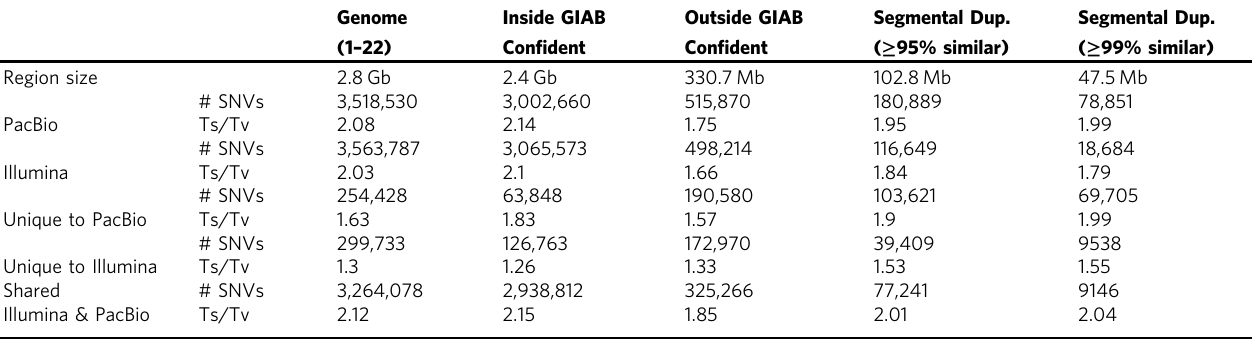
Table 2 Comparison of PacBio and Illumina SNV calls for NA12878 Genome Inside GIAB Outside GIAB Segmental Dup. Segmental Dup. Region